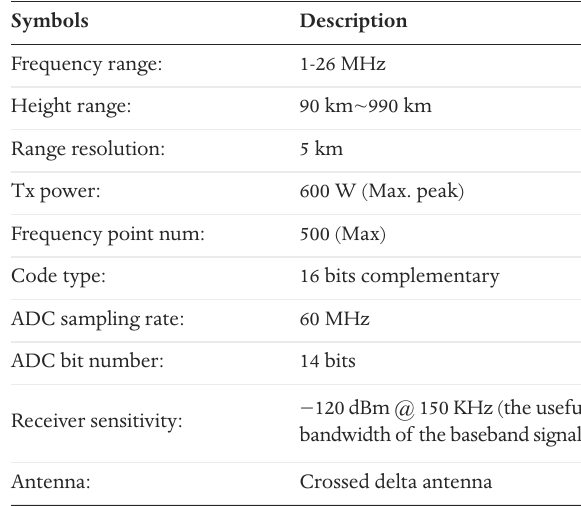
Table 1. CAS-DIS